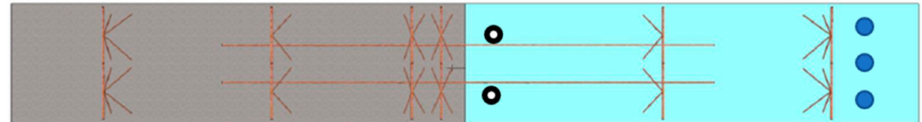
Figure 4. Configuration with Plexi plate (light blue surface), shear dowels (solid blue dots), and anchor rods